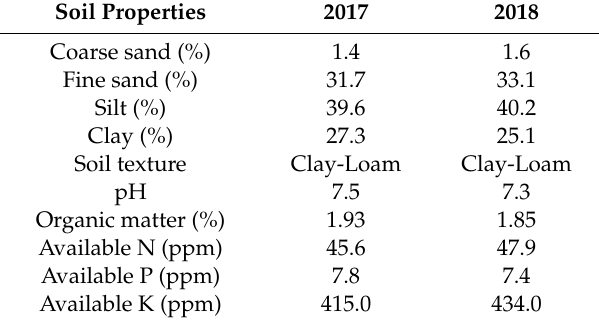
Table 1. Physical and chemical properties of the experimental soil in the two growing